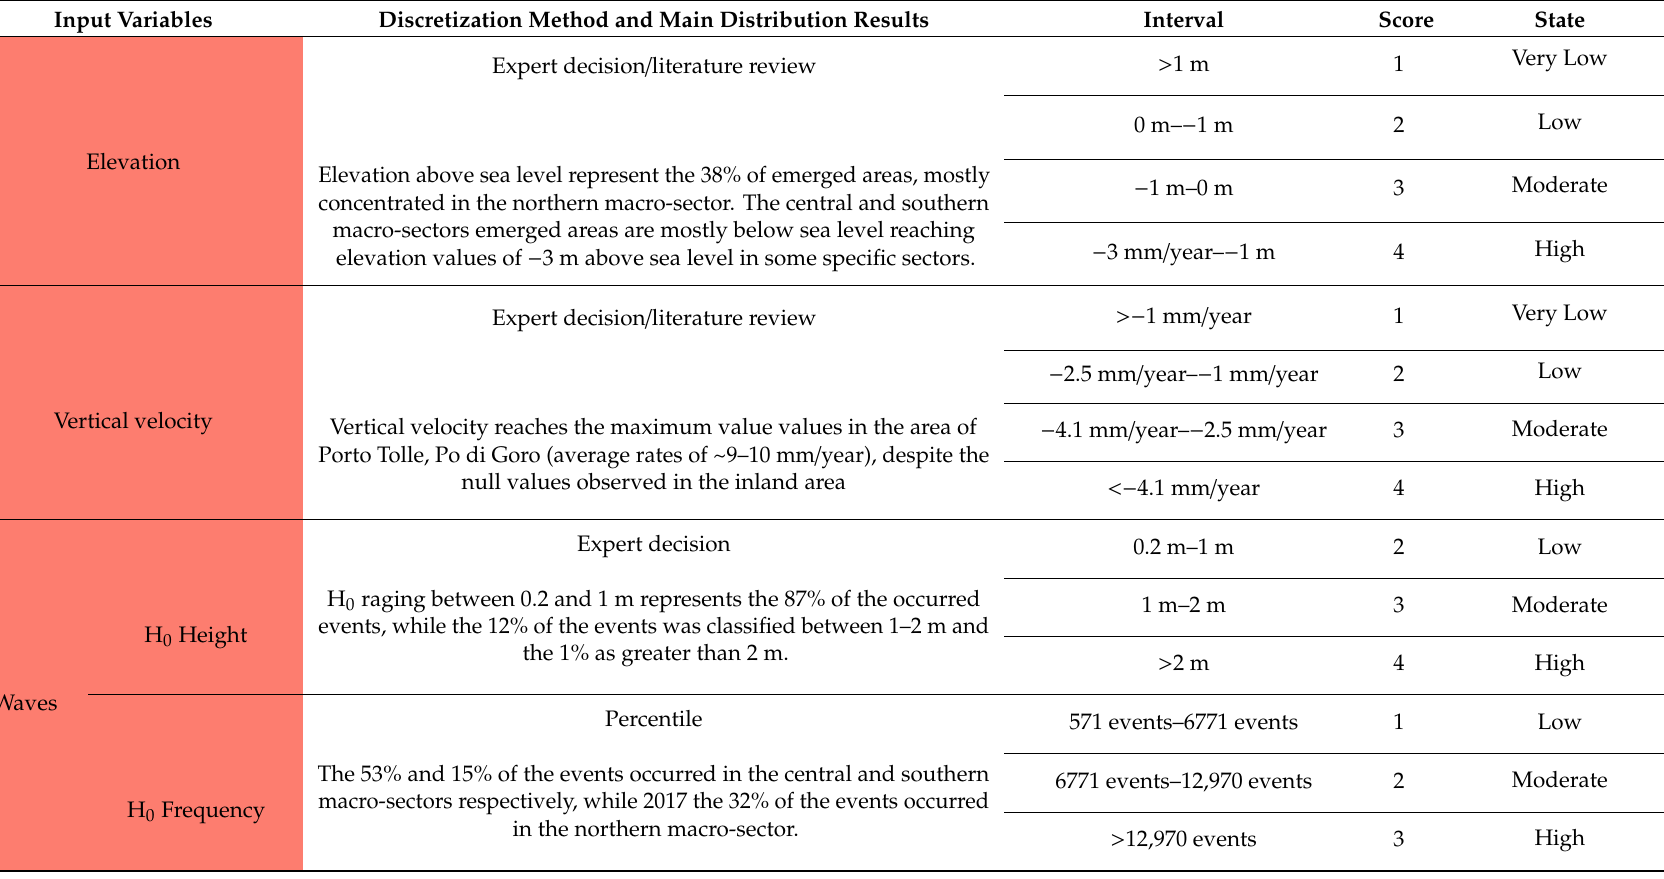
Table 3. Summary of variables included in the BBN, discretization methods applied and distribution classes, intervals, scores and states associated with the input variables identified in the vulnerability matrix for BBN model in the Po Delta area colored based on the types of variables representing the sources, driver factor (red), the pathway, land cover factor (green), the receptors, land use factor (blue). A score of 1 means a very low contribution to vulnerability, and a value of 4 means a high contribution to